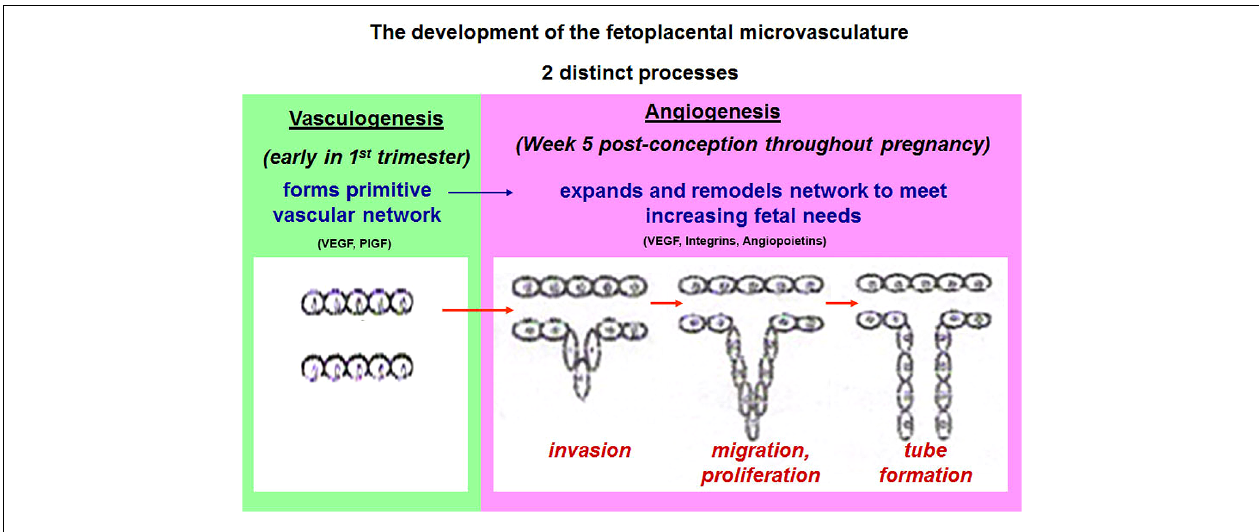
FIGURE 3 |A schematic representation of the distinct endothelial cell types in the human placenta. Differential expression of novel homeobox genes TGIF and MEIS2 in macrovascular HUVEC and HLX , DLX 3, DLX4 , TLX1 , TLX2 , and PHOX1 in freshly isolated placental endothelial cells (PLECs) are summarized. Figure adapted from Sato (2000), Kingdom etal. (2000).